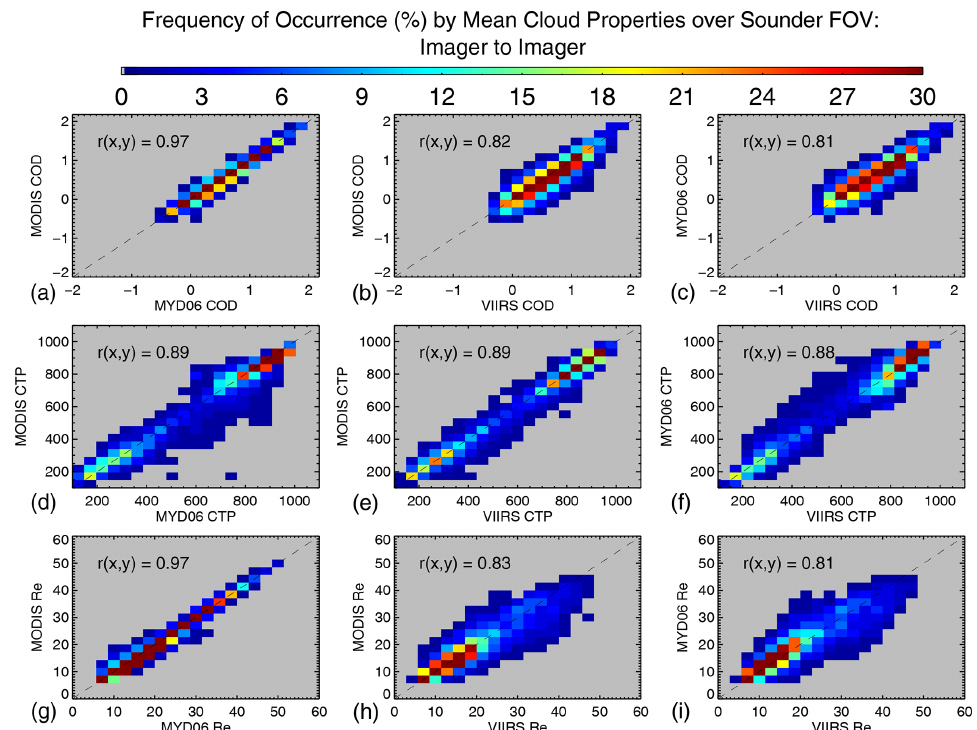
Figure 7. Comparison of cloud optical depth (COD, on a log 10 scale), cloud top pressure (CTP,hPa), and effective particle size ( R e , µm) retrieved by MODIS and VIIRS cloud algorithms. The mean imager cloud properties over corresponding sounder FOVs are compared over the SNOs. From left to right, results of the following comparisons: Aqua MODIS continuity cloud products (CLDPROP_MODIS) with MYD06, CLDPROP_MODIS with SNPP VIIRS continuity cloud products (CLDPROP_VIIRS), and MYD06 with CLDPROP_VIIRS, respectively. Linear correlation coefficients between the variables on the x and y axes are given in each